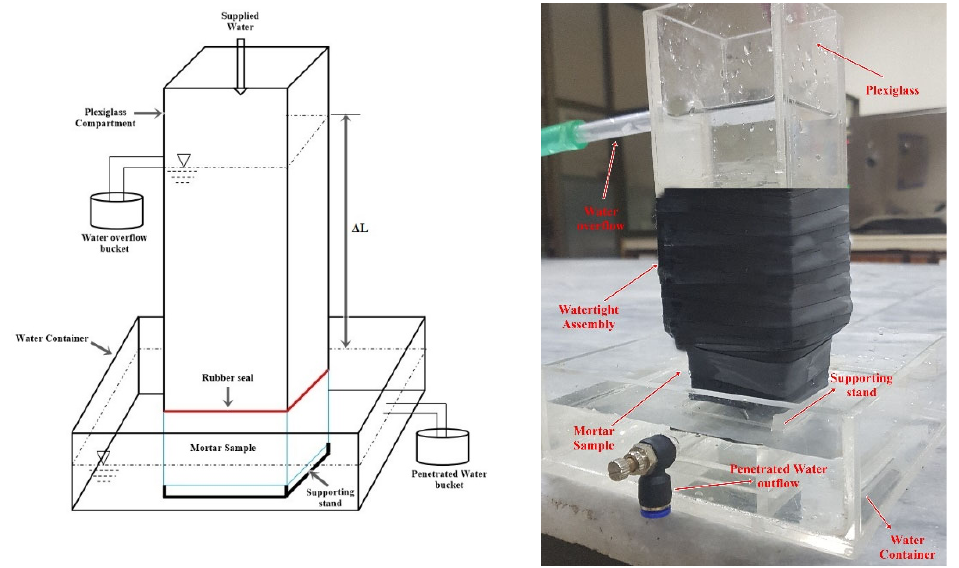
Figure 7. Permeability setup